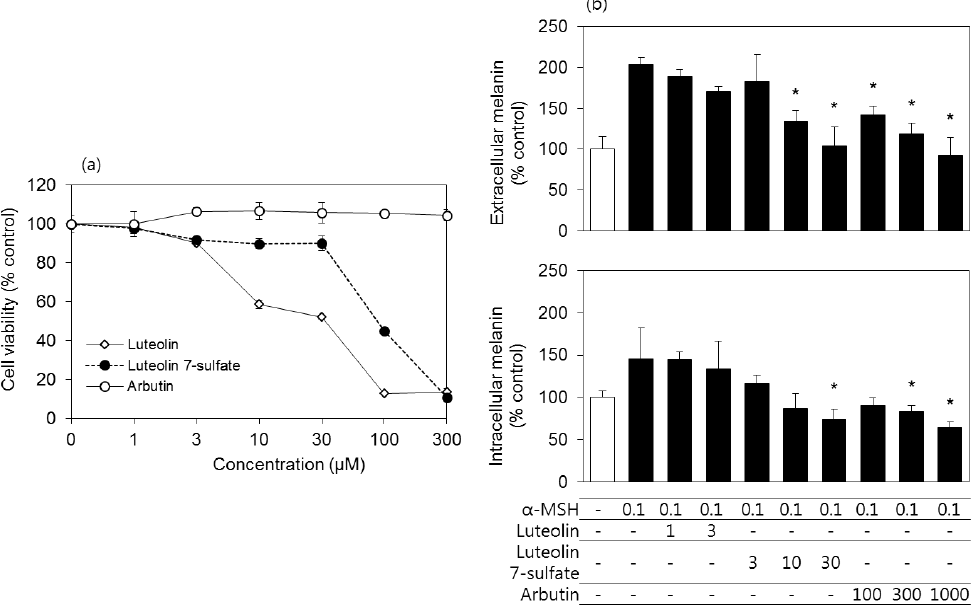
Figure 5. Effects of luteolin, luteolin 7-sulfate, and arbutin on the viability and melanin contents of human epidermal melanocytes. ( a ) Cells were treated with luteolin, luteolin 7-sulfate, or arbutin at varied concentrations, and the cell viability was determined after 48 h. ( b ) Cells were treated with luteolin, luteolin 7-sulfate, or arbutin at their non-toxic concentration ranges for 60 min and stimulated with 0.1 μM α-melanocyte-stimulating hormone (α-MSH), followed by a 48 h incubation. This procedure was repeated three times with medium change for 6 d. Extra- and intracellular melanin contents were corrected for total protein content of the cells. The means ± SEs of three independent experiments are presented. * p < 0.05 vs . α-MSH alone.